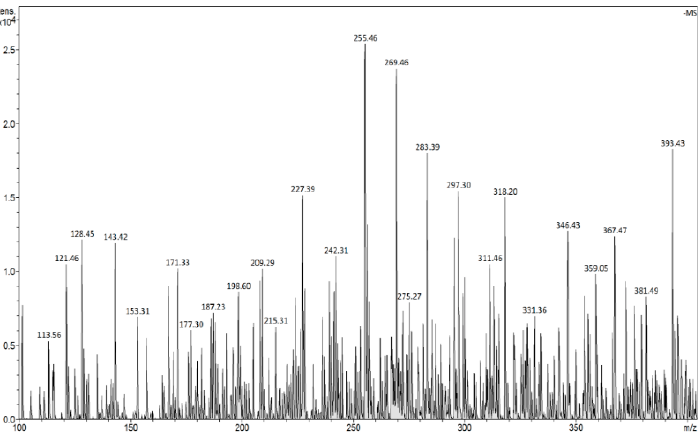
Molecules 2019 , 24 , x Figure 8. FAPA-MS spectrum of NIP in the range of negative ions. Figure 8. FAPA-MS spectrum of NIP in the range of negative ions. Figure 8. FAPA-MS spectrum of NIP in the range of negative ions.